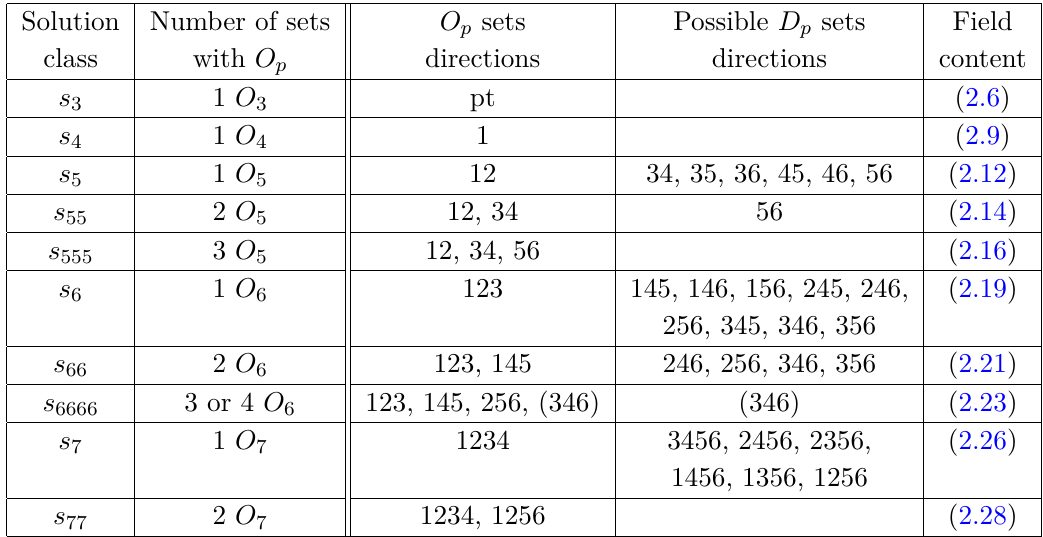
only wrap one internal dimension, so they cannot overlap; 5 few p = 5 , 6 is that O /D 4 4 more differences were pointed out in